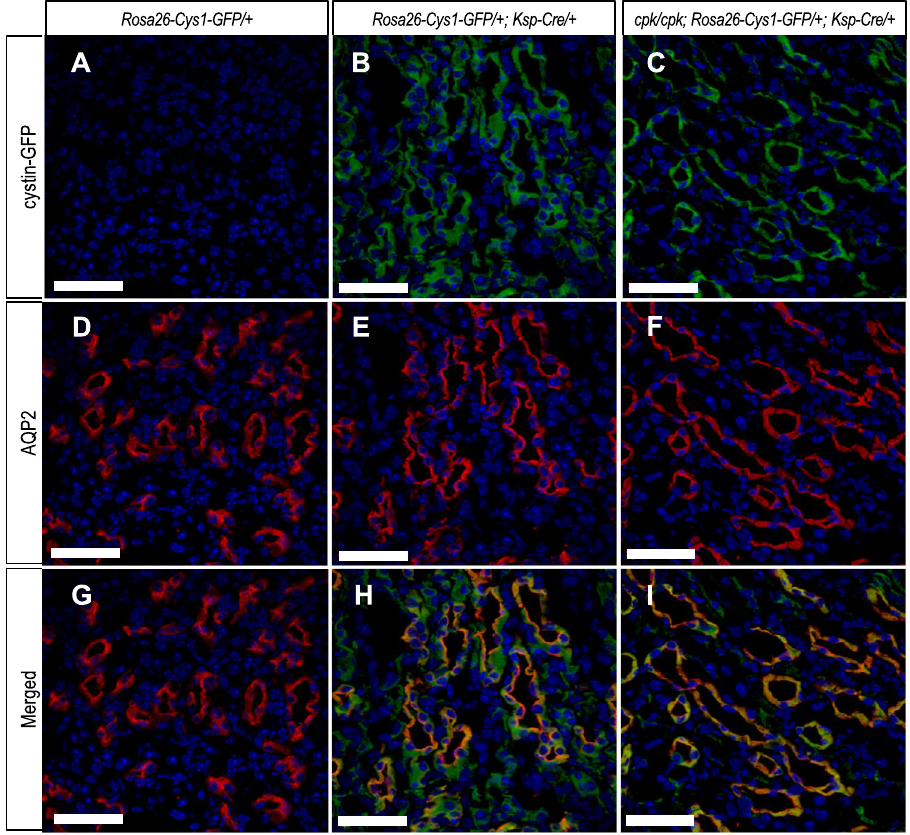
Figure 2. Cystin-GFP fusion protein expression in renal collecting duct. Immunohistochemical detection of cystin-GFP fusion protein (green, A – C ), AQP2 (red, D – F ) and merged ( G – I ) in kidney tissues from 6-week- old mice of the indicated genotypes. The Rosa26-Cys1-GFP/ + mice ( A , D , G ) do not express cystin-GFP fusion protein due to the absence of the Ksp-Cre transgene. The Rosa26-Cys1-GFP/ +; Ksp-Cre/ + mice ( B , E , H ) have a wild-type Cys1 gene and express cystin-GFP fusion protein in Cre-positive cells. The cpk/cpk; Rosa26-Cus1- GFP/ +; Ksp-Cre/ + rescue mice ( C , F , I ) express cystin-GFP fusion protein in Cre-positive cells. Cell nuclei are stained with DAPI (blue). Scale bars equal 50 µm. Images are representative of tissue sections from 3